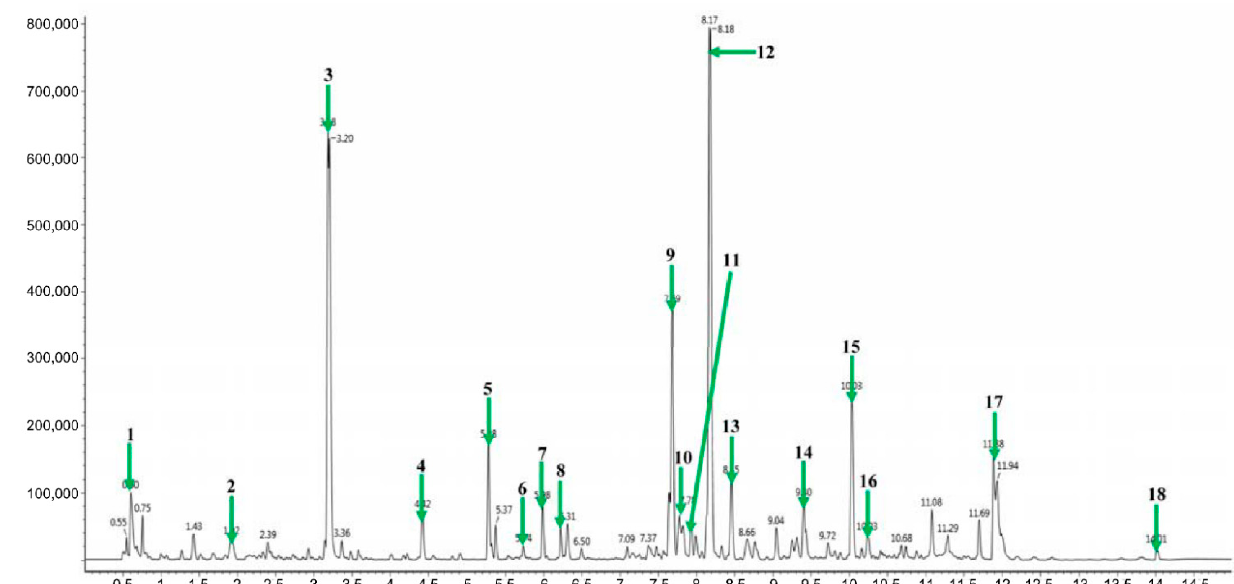
Figure 1. Representative ultra-performance liquid chromatography-quadrupole-time-of-flight mass spectrometry (UPLC- QTOF/MS) of extract (AYC-CS-E) isolated from culture supernatant of Aster yomena callus. For analysis, the metabolites were analyzed with a BEH C18 column (2.1 × 100 mm, 1.7 μ m). The eluted metabolites were analyzed by Q-TOF/MS in electrospray (ESI)-positive mode. The U PLC-QTOF/MS chromatogram shows the following: Green arrow 1, Robustic acid; green arrow 2, 3,4-Dicaffeoyl-1,5-quinolactone; green arrow 3, Acetylpterosin C; green arrow 4, Pterosin N; green arrow 5, L-thyronine; green arrow 6, 3,5-Di-O-methyl-8-prenylafzelechin-4beta-ol; green arrow 7, Dehydrophytosphingosine; green arrow 8, Phytosphingsoine; green arrow 9, LysoPC(18:2); green arrow 10, α -Linolenic acid; green arrows 11 and 12, LysoPC(16:0); 13, LysoPC(18:1); green arrow 14, LysoPC(18:0); green arrow 15, Palmitic amide; green arrow 16, Oleamide; green arrow 17, 13Z-Docosenamide; green arrow 18, PC(18:2/16:0).